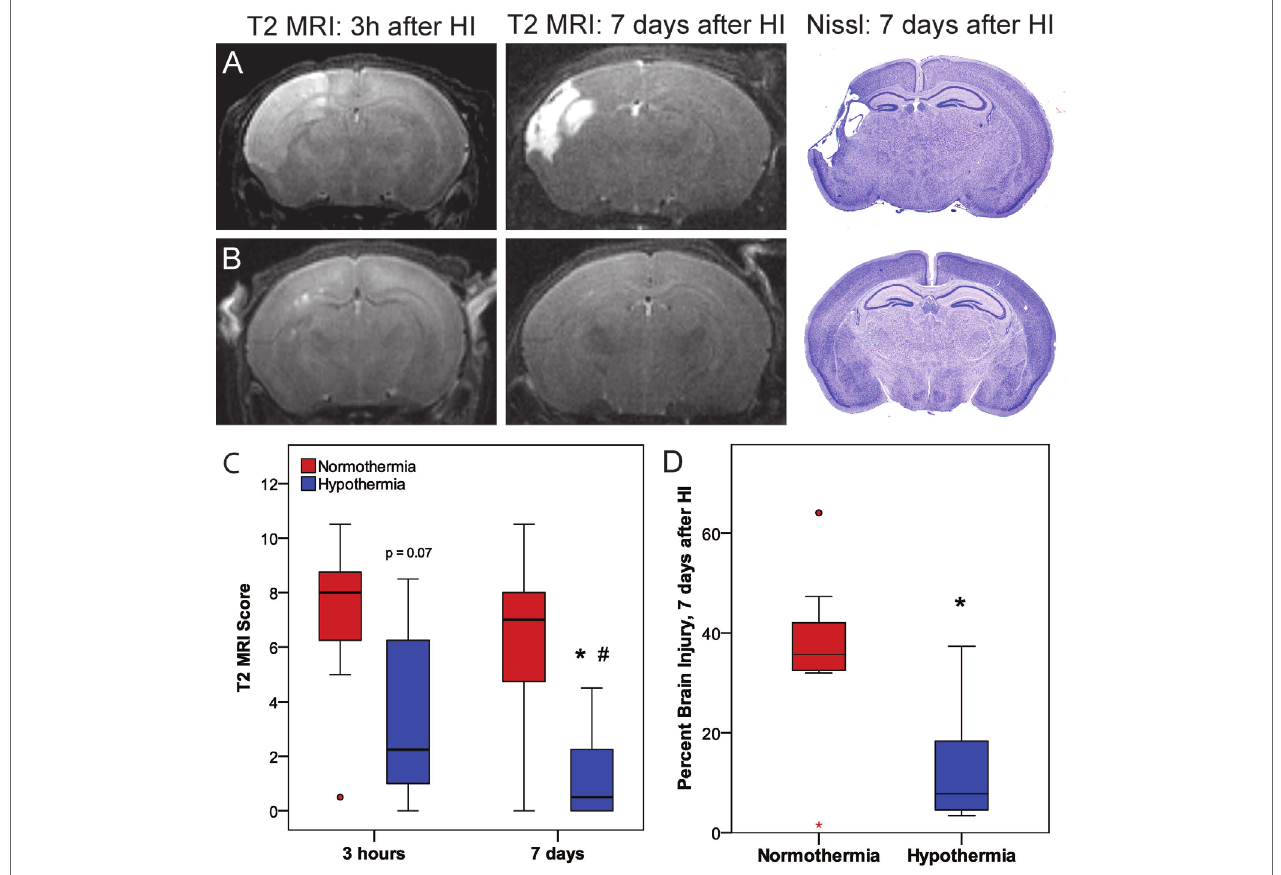
FigUre 5 | Phase 3: (a,B) representative T2 magnetic resonance imaging (MRI) obtained 3 h or 7 days after hypoxic ischemia (HI), with corresponding histopathology at 7 days in (a) normothermic or (B) hypothermic mice. (c) T2-weighted MRI scores at 3 h or 7 days after HI. With the smaller number of subjects examined in Phase 3 ( n = 7 or 8 per treatment group), there was a trend for lower T2 MRI scores in the hypothermic group at 3 h compared to the normothermic group at 3 h ( p = 0.072, Mann–Whitney U -test) and significantly lower T2 MRI scores in the hypothermic group at 7 days compared to the normothermic group at 7 days (* p < 0.05, Mann–Whitney U -test). In normothermic subjects, T2 MRI scores were comparable 3 h and 7 days after HI. Within the hypothermic group, T2 MRI scores were lower 7 days after HI than at 3 h (# p < 0.05, related samples Wilcoxon signed rank test). (D) The reduction in brain injury at 7 days in the hypothermic group was confirmed by histopathology (* p < 0.05, t